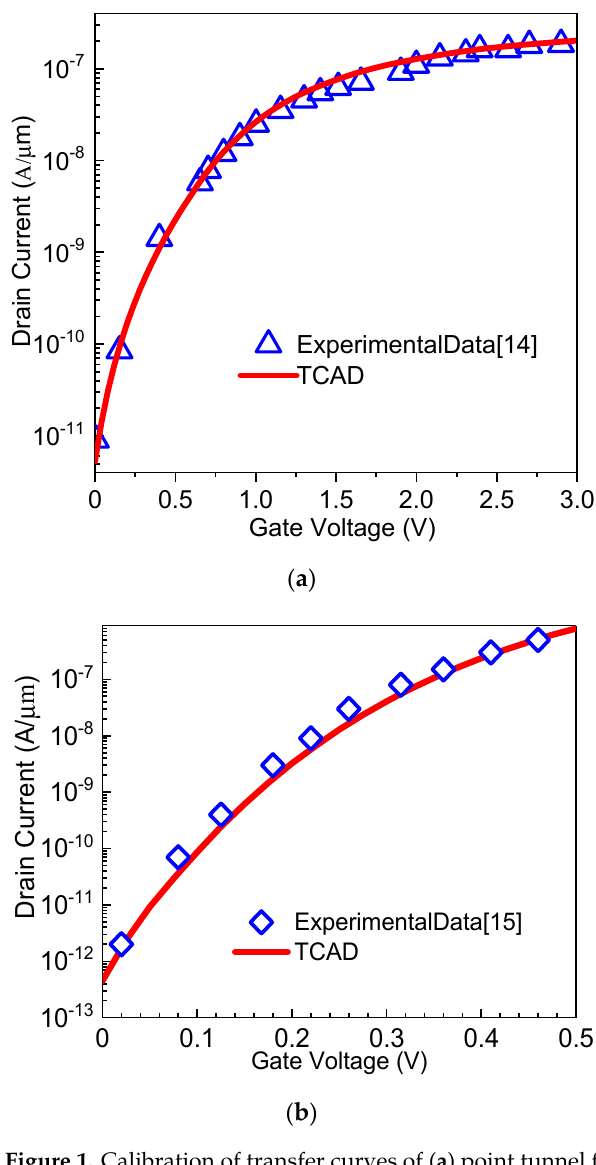
Figure 1. Calibration of transfer curves of ( a ) point tunnel field-effect transistor (TFET), line TFET and ( b ) Ge-source TFET using experimental data.